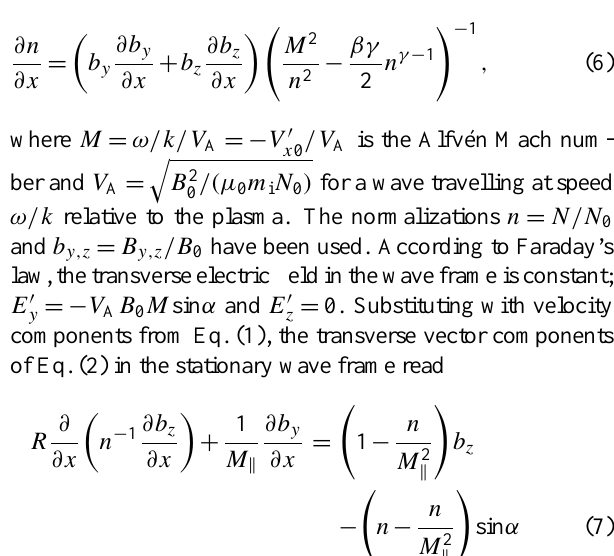
Fig. 3. Electron density profile averaged over 3min between 00:28:48UT and 00:31:48UT on 1 August 2007 measured by ESR. During the interval, there was no NEIAL or other abnormal spectral